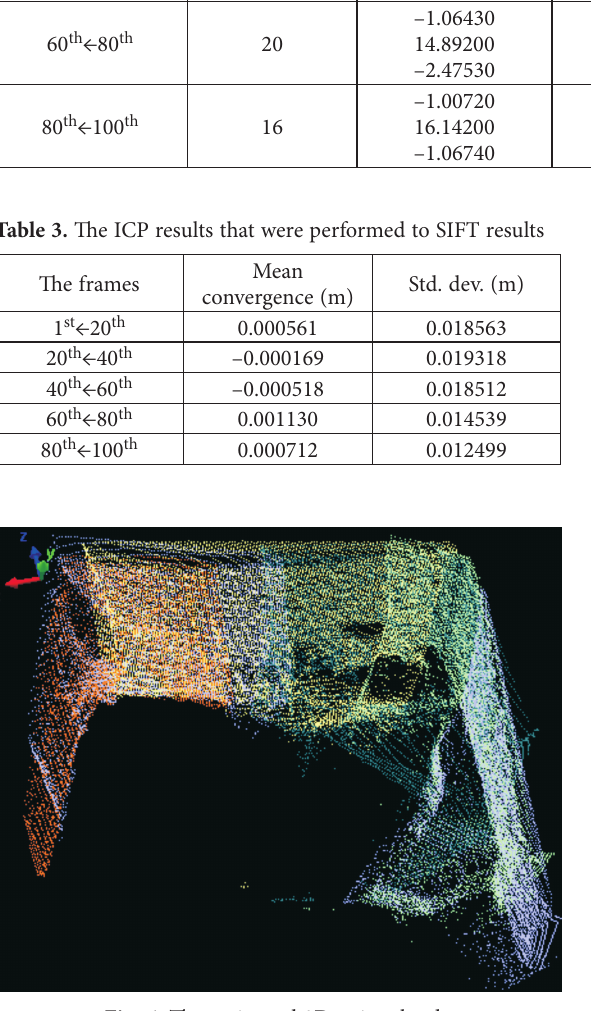
Fig. 6. The registered 3D point clouds of the measurement